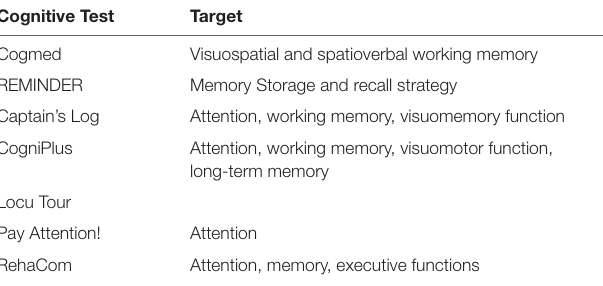
TABLE 3 | Common cognitive interventions.